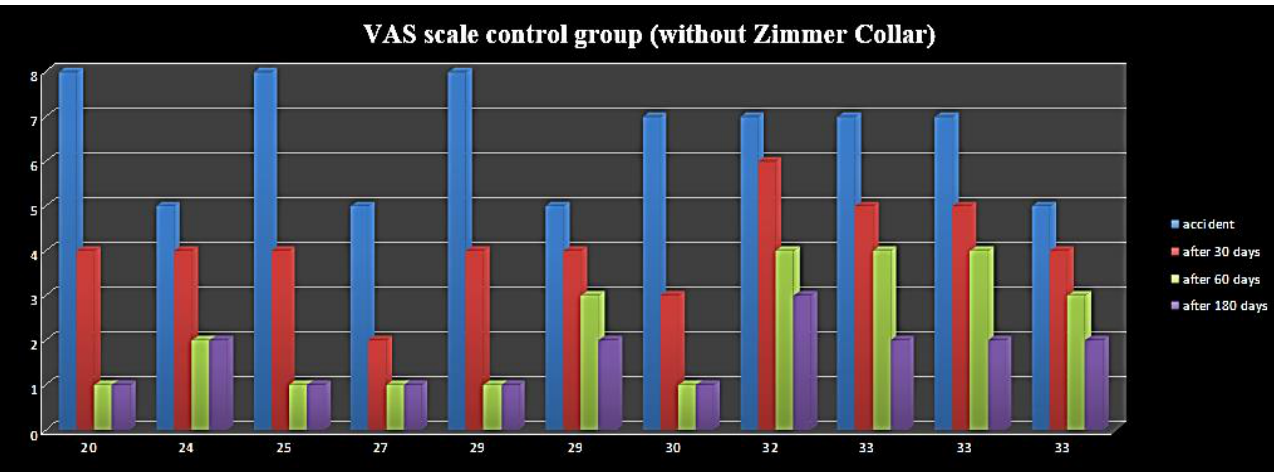
Figure 2. VAS scale control group (without Zimmer Collar).